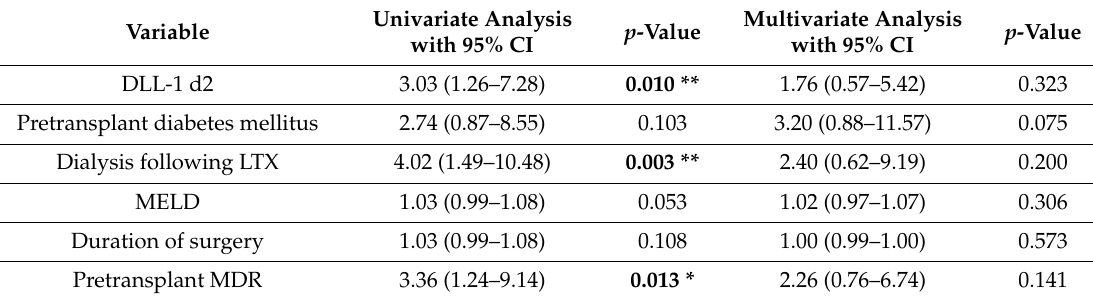
Table 3. Risk Factors for the Occurrence of Bacterial Infections Following